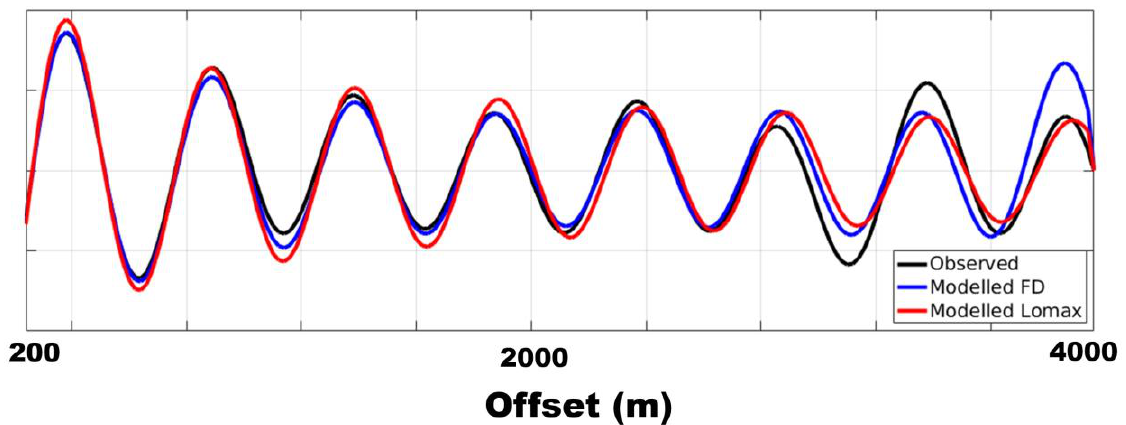
Figure 7. The seismic data in the frequency domain at frequency 3 Hz: black—observed data, calculated using finite differences in the true Marmousi model; blue—modeled data, computed using finite differences in the recovered model via standard FWI shown in Figure 5a; red—modeled data, calculated using frequency-dependent Lomax rays in the recovered model via asymptotic FWI shown on Figure 5b. Table 2. The MAPE value between the velocity models obtained via different inversion scenarios: v true is the true velocity model; v fd is the result of the classical full waveform inversion method; v asym is the result of the asymptotic inversion.